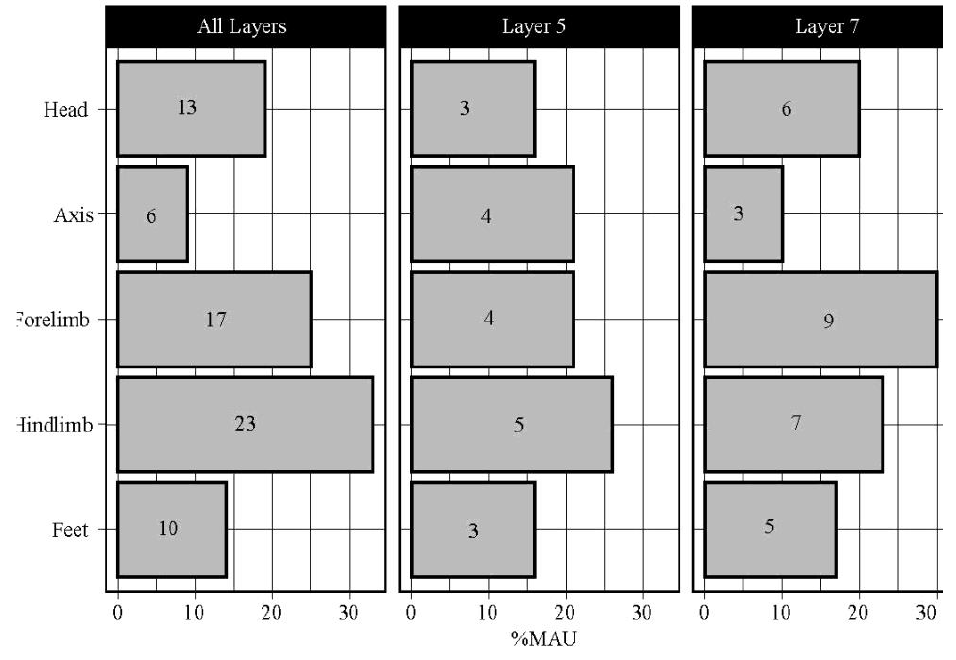
Figure 7: Skeletal element abundance profiles by anatomical region for caprine and gazelle sized bovids. Bar height is the percentage of the total MAU for all regions; numbers on the bars are frequencies. Head = cranium and mandible; axis = ribs and vertebrae; forelimb = scapula, humerus, radius and ulna; hindlimb = pelvis, femur, tibia, and tarsals; feet = metapodials and